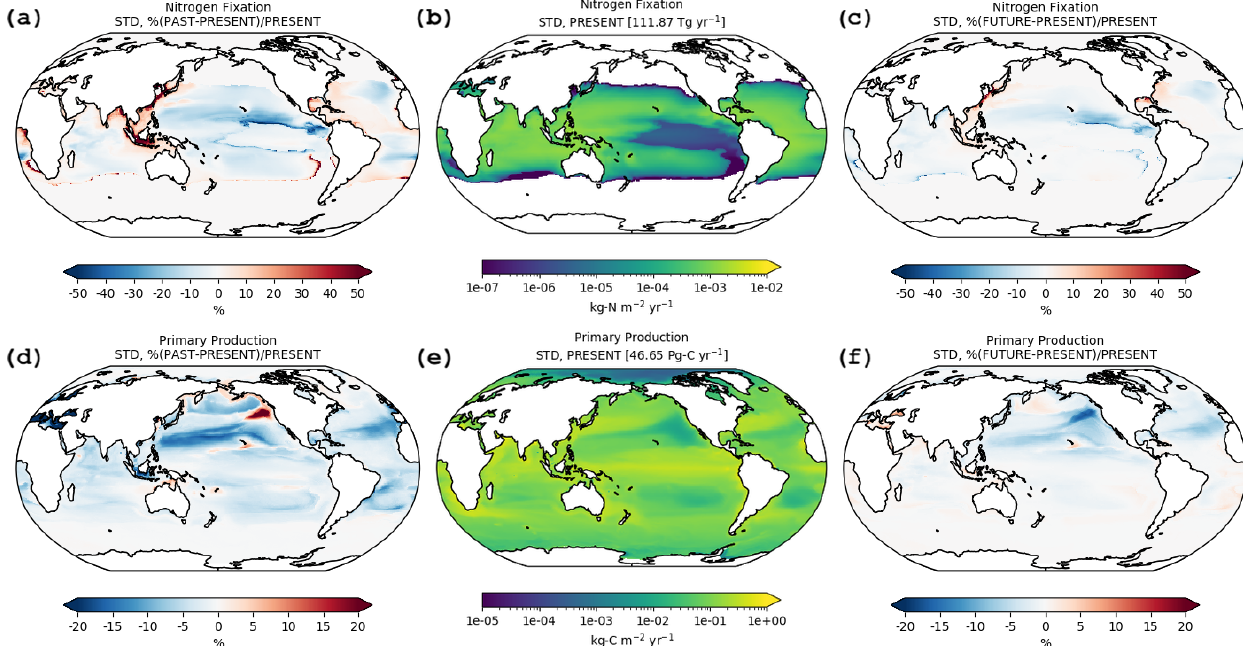
Figure 3. Nitrogen-fixation (kgNm − 2 yr − 1 ) and primary production (kgCm − 2 yr − 1 ) rates as calculated by the model for PRESENT (b, e) for the STD simulation, and the respective relative differences (%) compared to PAST (a, d) and FUTURE (c, f)